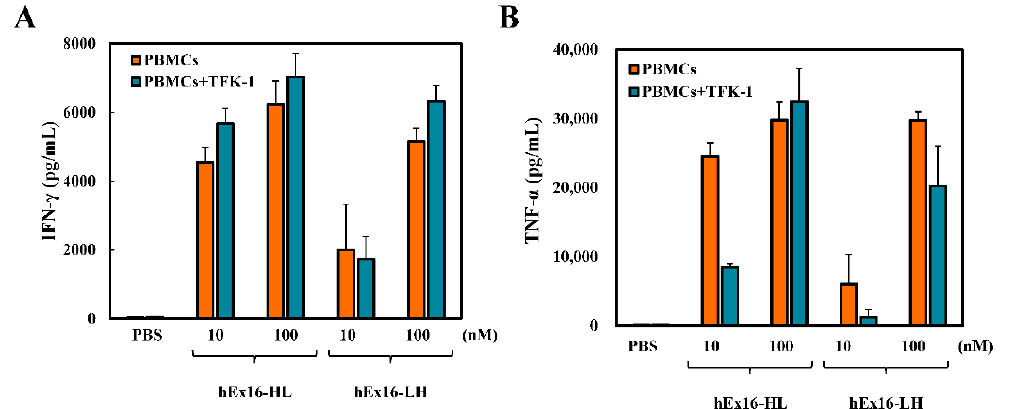
Figure 5. hEx16-Dbs-mediated cytokine production by PBMCs. PBMCs were cultured with hEx16-Dbs, either in the presence or absence of TFK-1 cells. Concentrations of ( A ) IFN- γ and ( B ) TNF- α were evaluated using enzyme-linked immunosorbent assays.